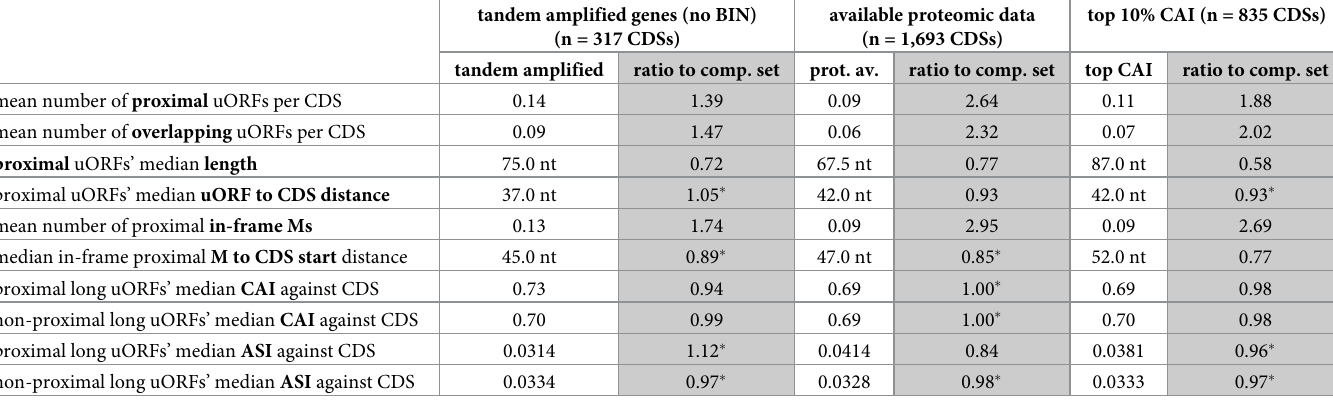
Table 1. Summary of uORFs preceding highly expressed